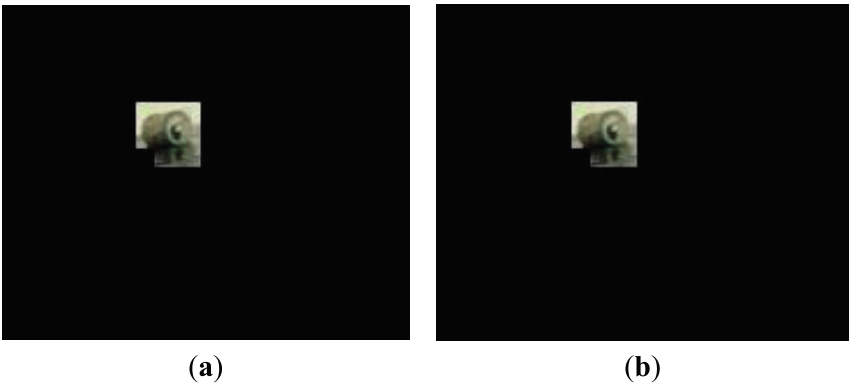
Figure 8. Image sparse representation and recovery. ( a ) Debris image; ( b ) Recovered image ( err =